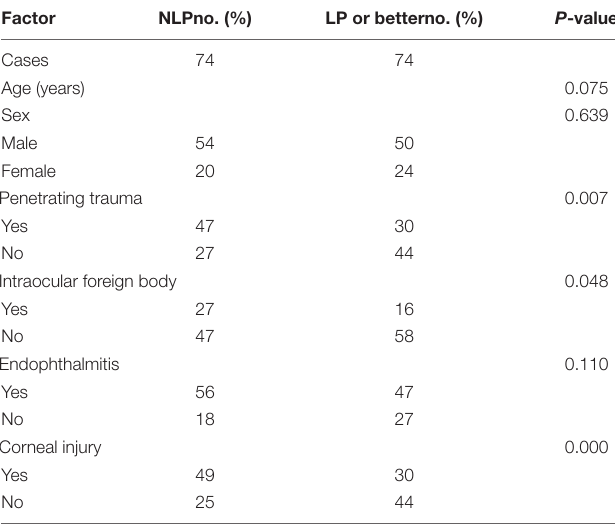
TABLE 1 | Univariate analysis of the risk factors for NLP in patients with OC.